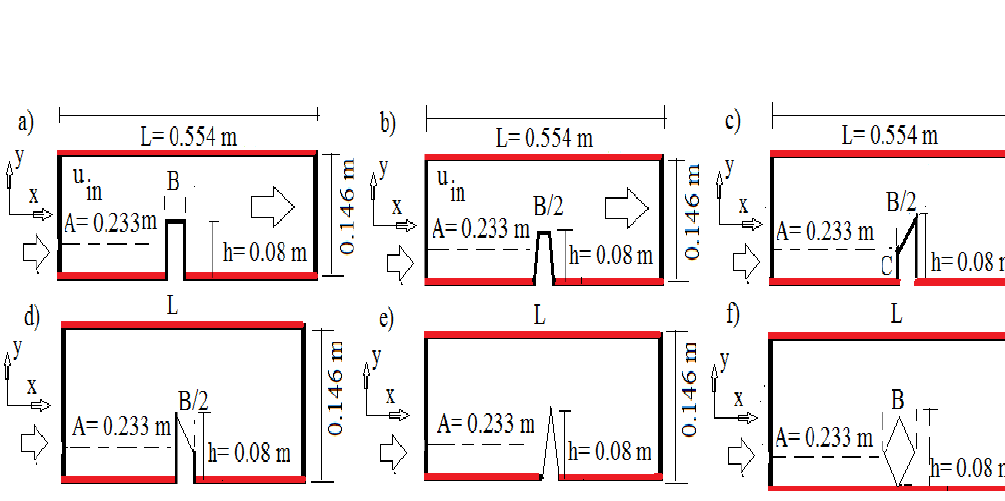
Figure 1. Schematic diagrams of rectangular channel with different forms of